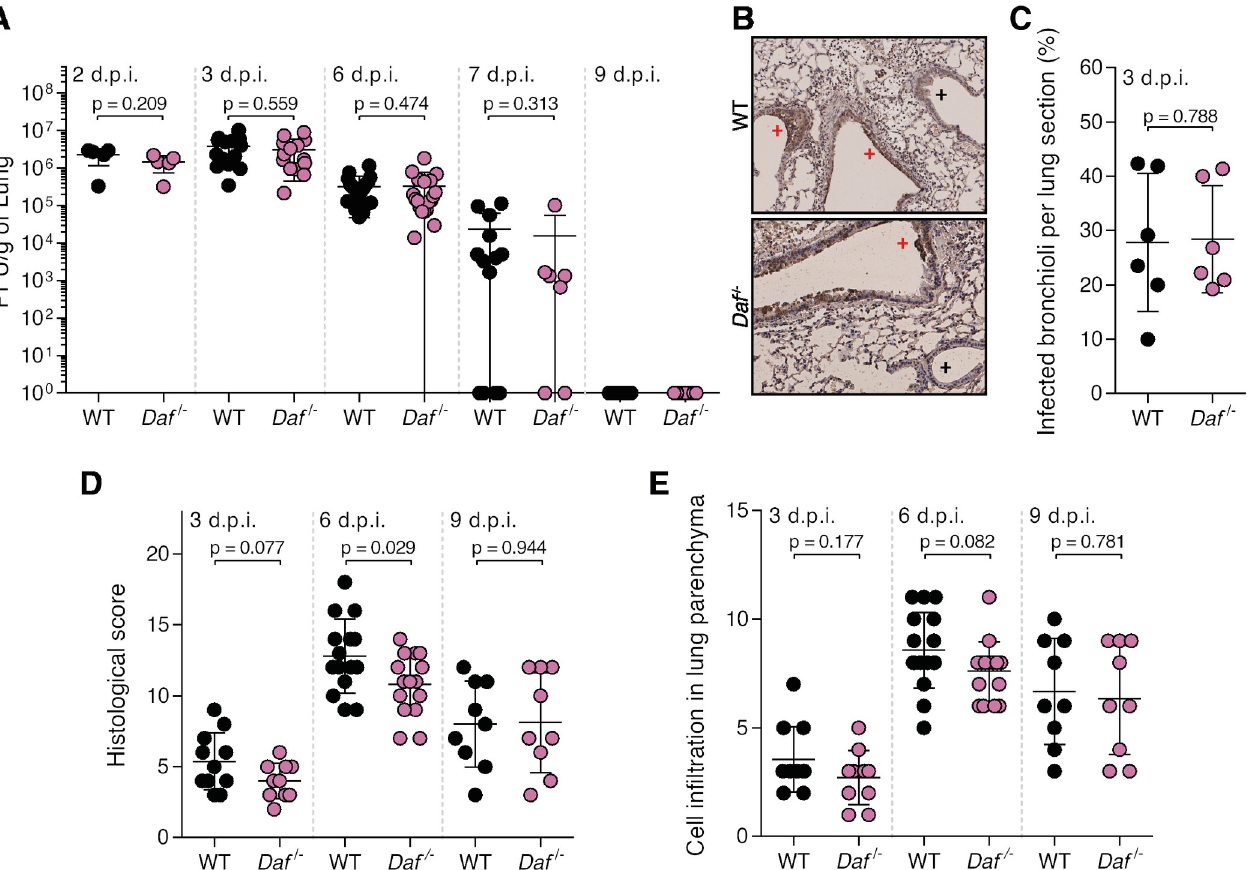
Fig 3. DAF does not affect viral replication, clearance, or tissue penetration, but is an immunopathology instigator. A: Lung viral titers of C57BL/6J WT or Daf -/- mice infected with 1000 PFU of A/X-31 (PR8-HK4,6). Samples collected at 2 d.p.i. (n = 5 per group); 3 d.p.i. (n = 14 per group), 6 d.p.i. (n = 20 and n = 19 for WT and Daf -/- respectively), 7 d.p.i. (n = 13 and n = 7 for WT and Daf -/- respectively) and 9 d.p.i. (n = 9 per group). B : Immunohistochemistry detection of IAV nucleoprotein (NP) in WT or Daf -/- mice 3 d.p.i. with 1000 PFU of PR8-HK4,6 (+ healthy; + infected). C : Quantification of infected bronchioli (n = 6 per group). D, E : Histological score ( D ) and cell infiltration in lung parenchyma ( E ) of C57BL/6J WT or Daf -/- mice infected with 1000 PFU of PR8-HK4,6 was assessed blindly. Evaluated parameters detailed in S1 Table. Samples collected at 3 d.p.i. (n = 11 and n = 10 for WT and Daf -/- respectively), 6 d.p.i. (n = 15 per group) and 9 d.p.i. (n = 9 per group). Results are expressed as mean ± sd. Statistical analysis detailed in materials and